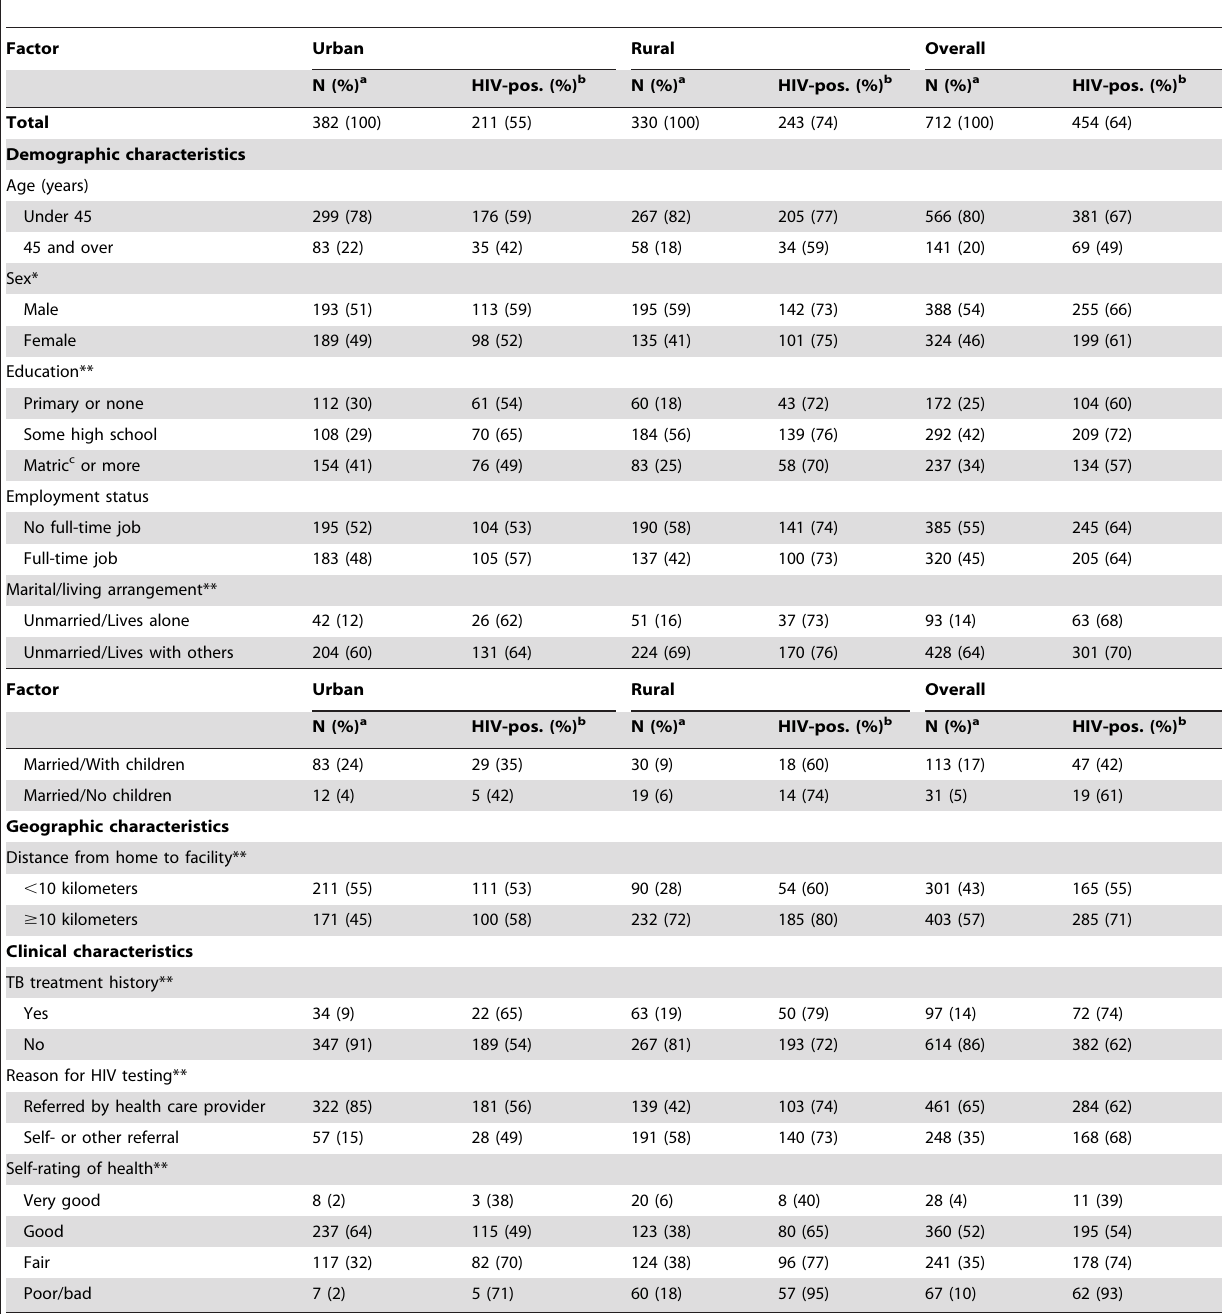
Table 1. Site-stratified and overall characteristics of a cohort of persons presenting for HIV testing in two PEPFAR sites, Durban, South